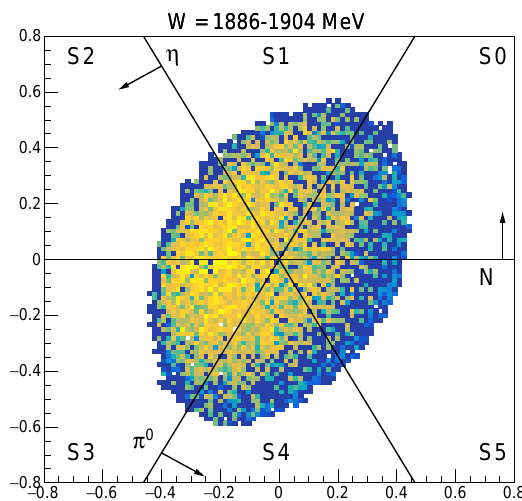
Figure 4. Van Hove plot for γ p → ηπ 0 p in the energy range = 1426–1462 MeV. The six sectors S0 to S5 represent di ff erent E γ combinations of forward or backward going particles (see